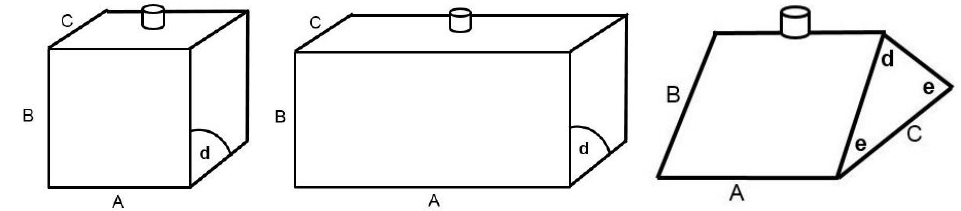
Figure 1. Sketches of the three block shapes used in the experiment. From left to right: cube, brick, and wedge, respectively. The position of the attachment skewer, using a 10-mm diameter metal pin inserted vertically through the block, is also shown in the diagrams. The different letters shown with the shapes refer to respective measurements of side length ( upper case ) or corner angles ( lower case ). The measurements are provided in Table 1 for each block shape prepared for sucker compared to weaner pigs. Table 1. Dimensions and angles identified in Figure 1 for the different shaped blocks provided for sucker and weaner pigs in the experiment. Measurements shown are